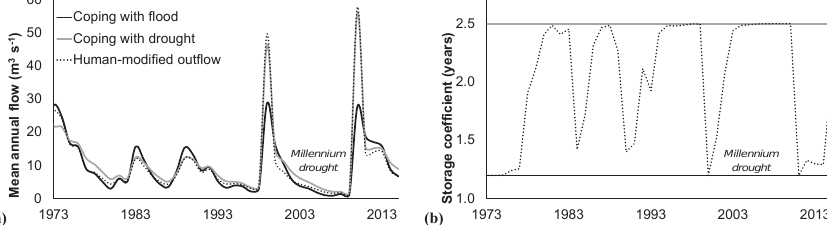
Figure 6. Example of drought after flood. (a) Human-modified outflows (dotted line) that result from changing storage coefficient (b) , between the values aiming to cope with flood (black continuous line) and aiming to cope with drought (grey